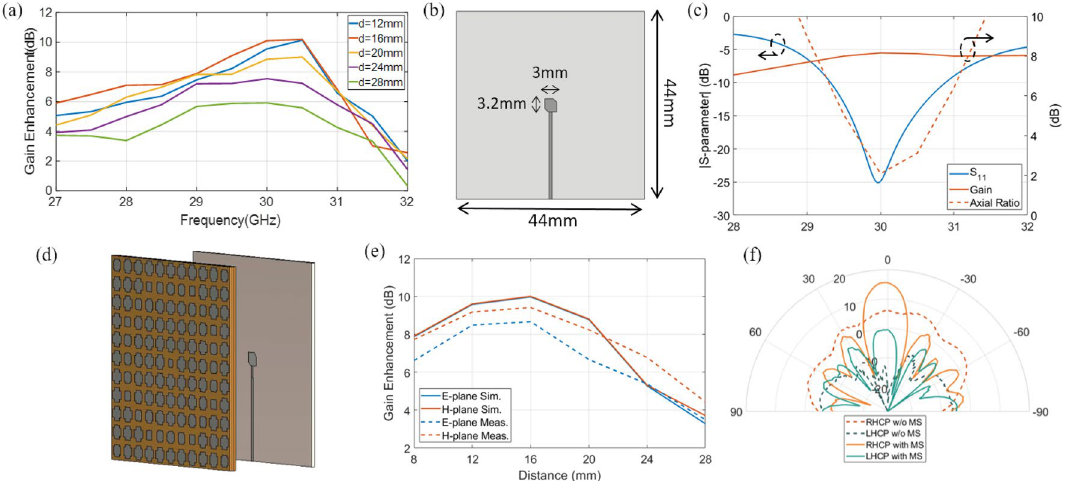
Figure 5. ( a ) Measured antenna gain enhancement of the metasurface superstrate according to the frequency and distance. ( b ) Designed circularly polarized patch antenna with its dimension. ( c ) The characteristics